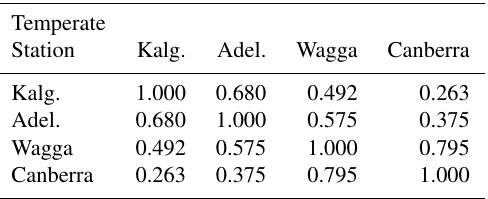
Table 6. Pearson’s correlation coefficient between all temperate sta- tion pairs, for stations with time series of 60 months or greater. Temperate Station Kalg. Adel. Wagga Canberra Kalg. 1.000 0.680 0.492 0.263 Adel. 0.680 1.000 0.575